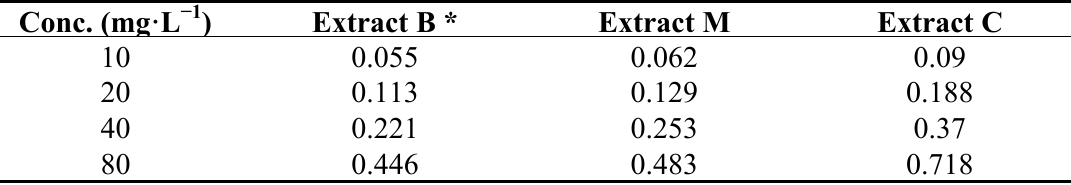
Table 3. Optical densities * of extracts B, M, and C at 565